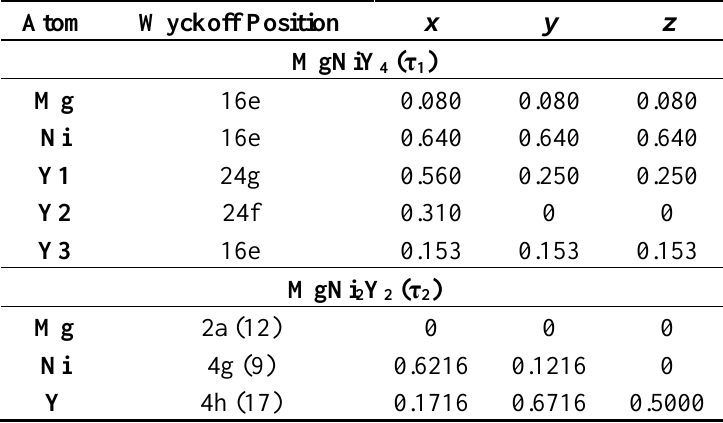
Table 4. Atoms position in the unit cell of τ 1 and τ 2